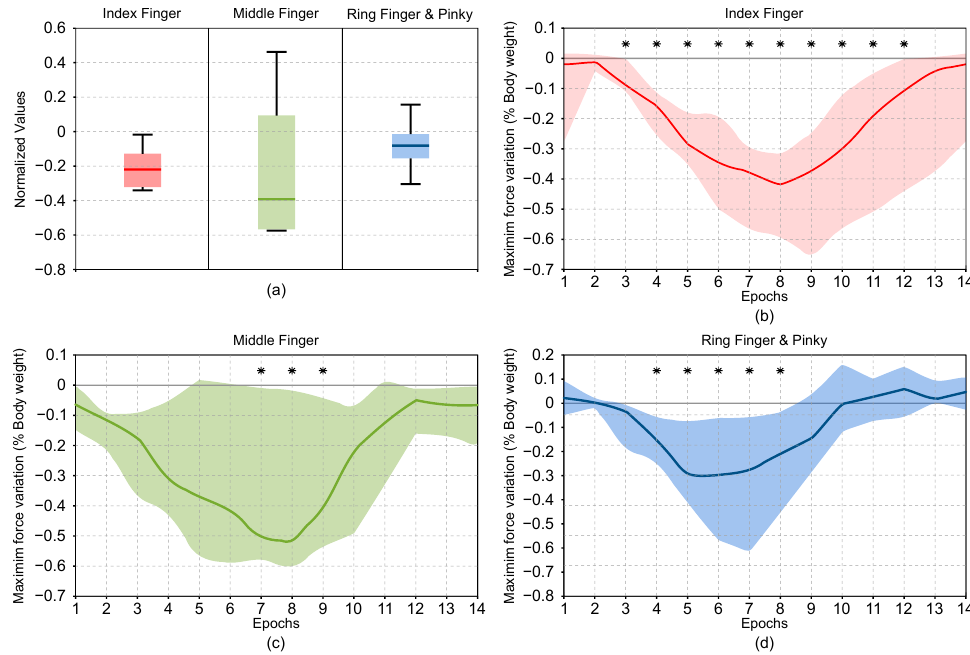
Figure 6. Results of the variation of the exoskeleton interaction forces. ( a ) Box plots of the exoskeleton interaction forces of all the subjects in every condition. ( b ) Evolution of interaction force of the index finger by epochs of 200 ms. ( c ) Evolution of interaction force of the middle finger by epochs of 200 ms. ( d ) Evolution of interaction force of the ring and pinky fingers by epochs of 200 ms. Shaded areas contains all the mean values of all participants. Asterisk indicates a significant difference from the reference of the force interaction in that epoch. In all graphs, positive values indicate a force that tries to open the finger modules of the hand exoskeleton. Negative values indicate a force that tries to close the finger modules of the hand